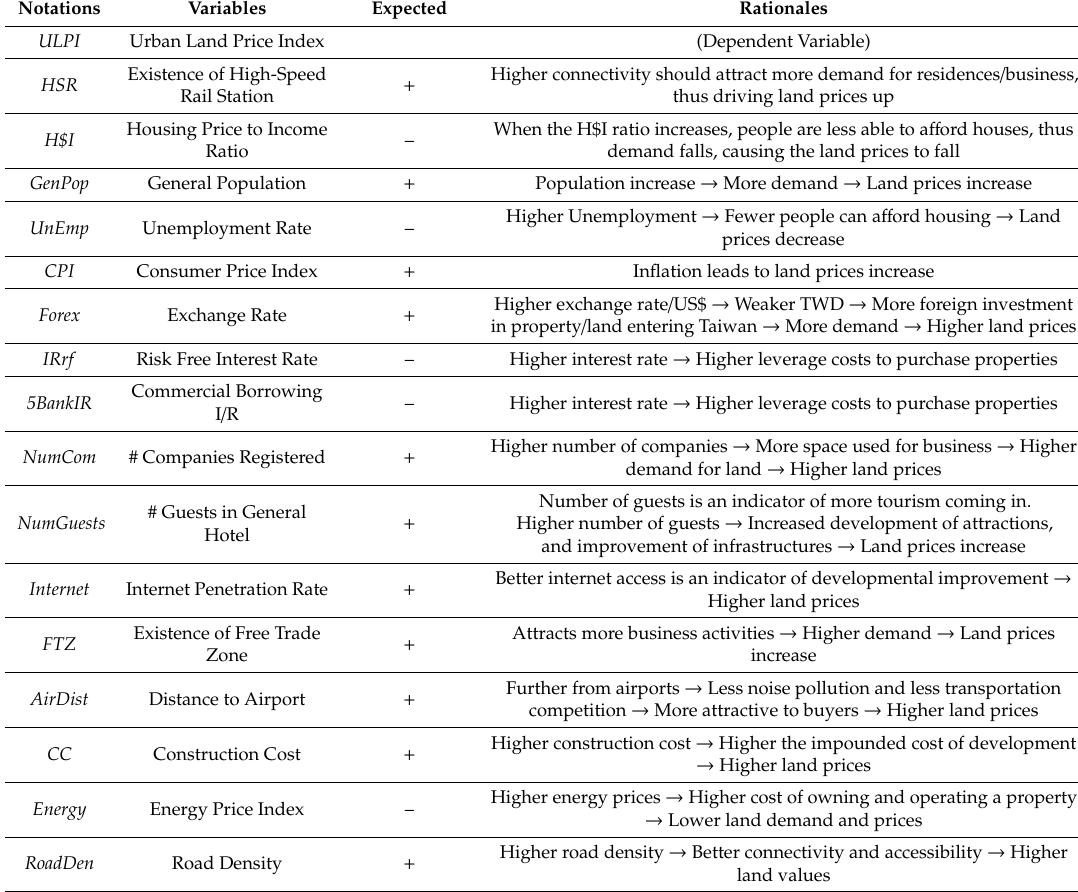
Table 2. Possible factors a ff ecting land